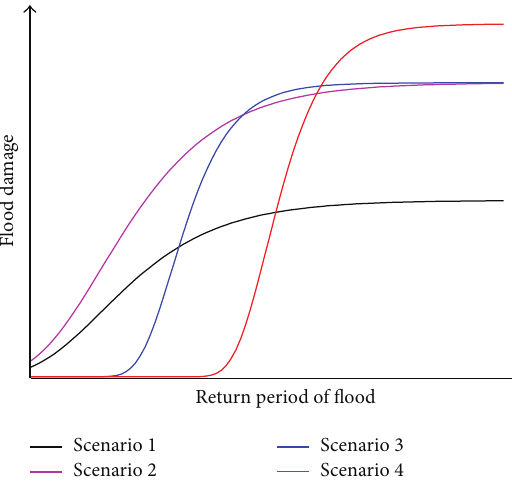
Figure 6: Conceptual 𝑅 - 𝐷 function